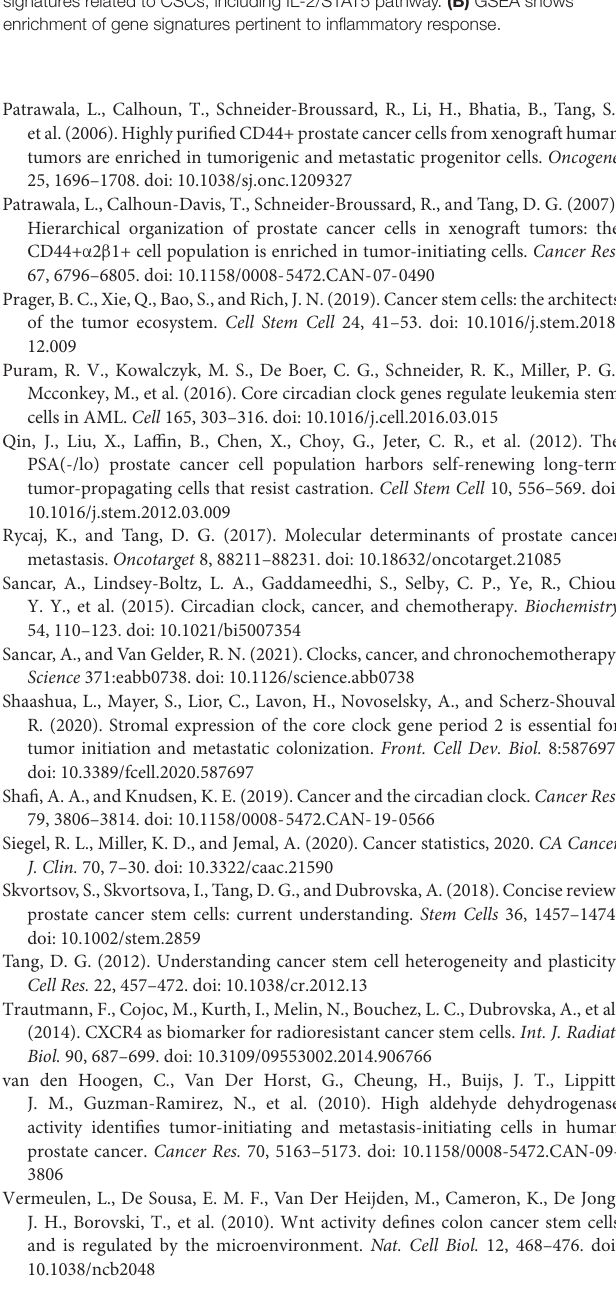
Supplementary Figure 1 | Bioinformatic analysis of RNA-Seq in PC3 DP cells compared to PC3 DN cells. (A) High consistency in the biological triplicates were shown in the correlation plot. (B) Proper distribution of fpkm of each analyzed sample was shown in the violin plot. Supplementary Figure 2 | GSEA shows enrichment of gene signatures in PC3 DP cells compared to DN cells in TME. (A) GSEA shows enrichment of gene signatures related to CSCs, including IL-2/STAT5 pathway. (B) GSEA shows enrichment of gene signatures pertinent to inflammatory